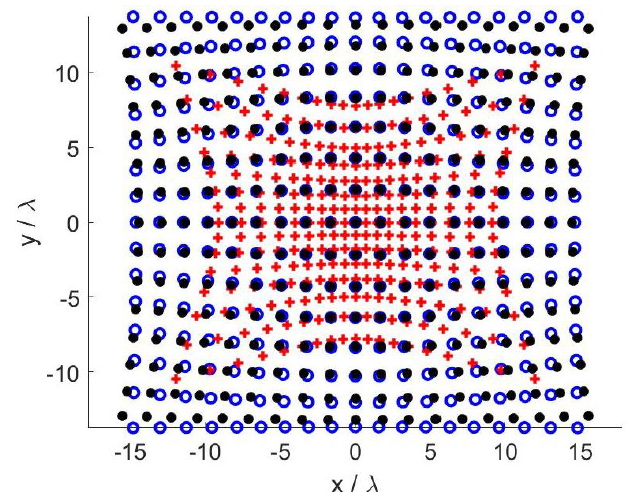
Figure 4. Case A—Optimized sampling points. Blue circles: Shannon number. Black dots: Mutual information. Red pluses: Fisher information.